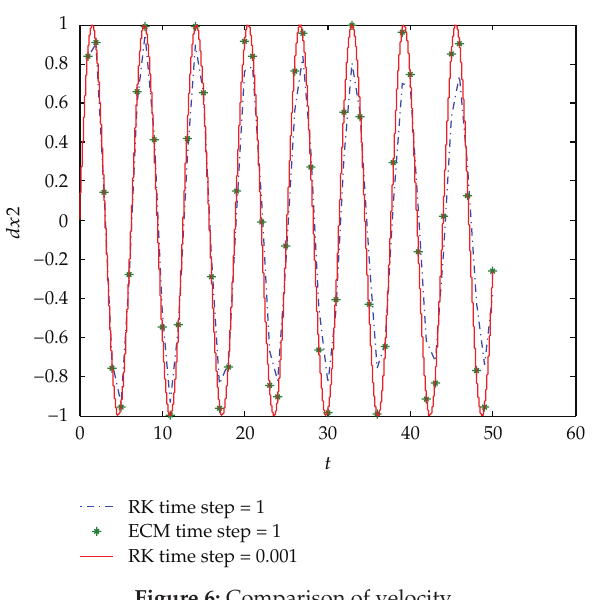
Figure 6: Comparison of velocity.